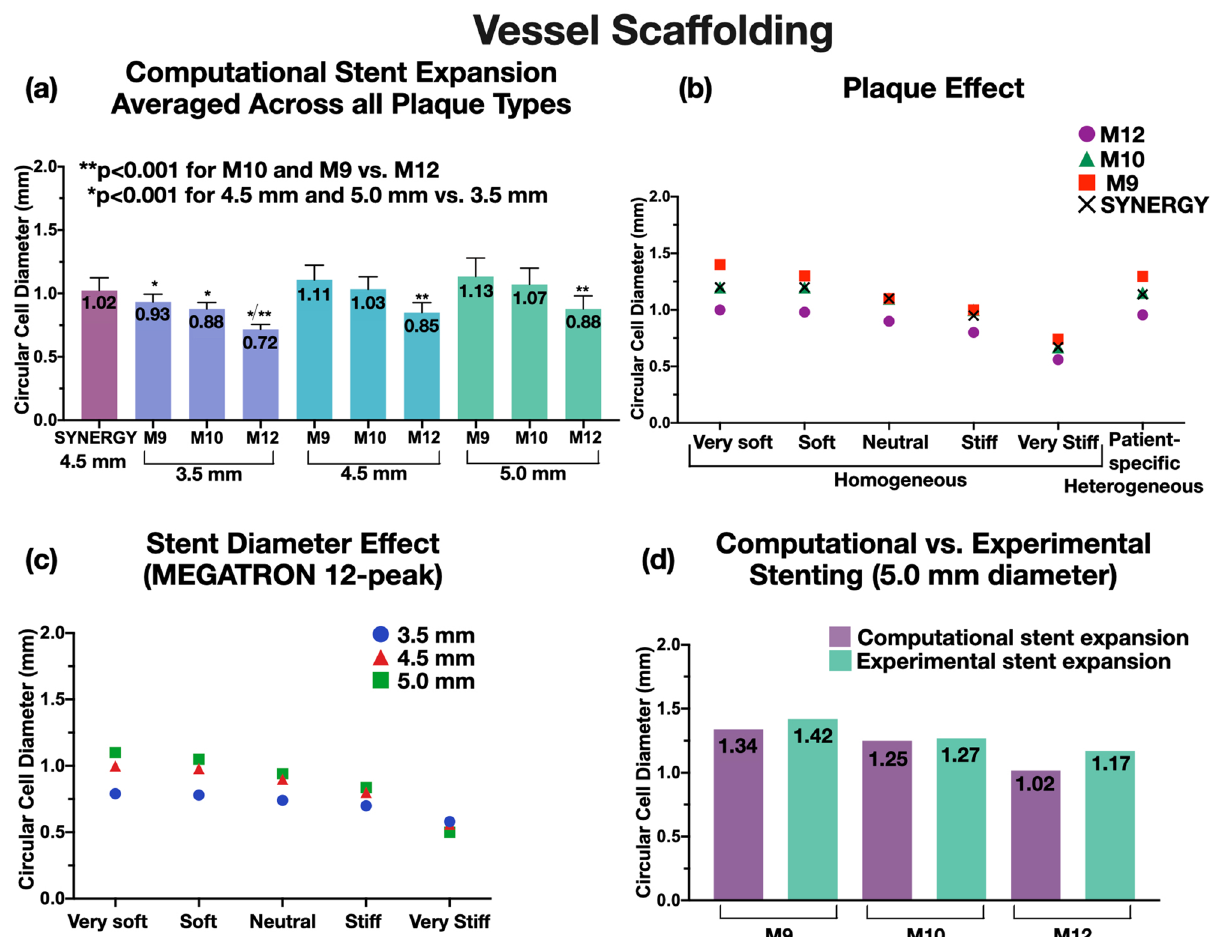
Figure 6. Vessel scaffolding (computational vs. experimental). Vessel scaffolding was expressed by circular cell diameter (CCD). ( a ) CCD across different stent designs and plaque types revealed that 12-peak MEGATRON had significantly better scaffolding than the other stent designs, ( b ) 12-peak MEGATRON expanded to 4.5 mm across different homogeneous and heterogeneous plaque material had smaller CCD (better scaffolding) compared to the other stent designs, ( c ) CCD of 12-peak MEGATRON across different stent diameters and plaque materials revealed that smaller diameter stents had better scaffolding than larger stents, ( d ) Computational and experimental CCD was comparable across all MEGATRON stent designs; M12: MEGATRON 12-peak, M10: MEGATRON 10-peak, M9: MEGATRON higher the MSD (Fig. 5a–d). This effect was consistent across all stent expansion diameters i.e. 3.5 mm (Fig. 5a), 4.5 mm (Fig. 5b), and 5.0 mm (Fig. 5c). SYNERGY expansion pattern was comparable to 9-peak MEGATRON (Fig. 5b,d). Table 3 shows the percentage difference in stent expansion from 9-peak to 12-peak MEGATRON under different homogeneous plaque conditions. Of note, the difference in expansion of 12-peak vs. 10-peak vs. 9-peak MEGATRON vs. Synergy was amplified when stents were expanded against homogeneous soft or neutral plaque conditions. In contrast, stent expansion of 12-peak, 10-peak and 9-peak MEGATRON, and SYNERGY was similar in the extremes of homogeneous plaque conditions, i.e. very soft or very stiff plaque (Fig. 5a–c). Het- erogeneous patient-specific plaques exhibited similar stiffness pattern to homogeneous soft plaques (Fig. 5b,d). Vessel scaffolding. Computational analysis. Vessel scaffolding computational analysis represented by CCD showed that 12-peak MEGATRON had significantly smaller CCD ( p < 0.001), and hence, better scaffold- ing than 9-peak MEGATRON, 10-peak MEGATRON, or SYNERGY across all homogeneous and heterogene- ous plaque materials and expansion diameters (Fig. 6a,c,d). SYNERGY’s scaffolding performance was closer to 10-peak MEGATRON. The difference in vessel scaffolding of 12-peak vs. 10-peak vs. 9-peak MEGATRON was greatly attenuated with homogeneously stiffer plaques (Fig. 6b). With regards to stent expansion diameters, stents expanded to 5.0 mm or 4.5 mm had significantly larger CCD than 3.5 mm stents ( p < 0.001) across all stent designs, and this difference was also attenuated with homogeneous stiffer plaques (Fig. 6c). Overall, these results show that stents expanding against stiffer plaques achieve lumen scaffolding in the expense of suboptimal expansion (“Computational stent expansion” section). Heterogeneous patient-specific plaques were similar to homogeneous soft plaque in terms of vascular scaffolding (Fig. 6b).